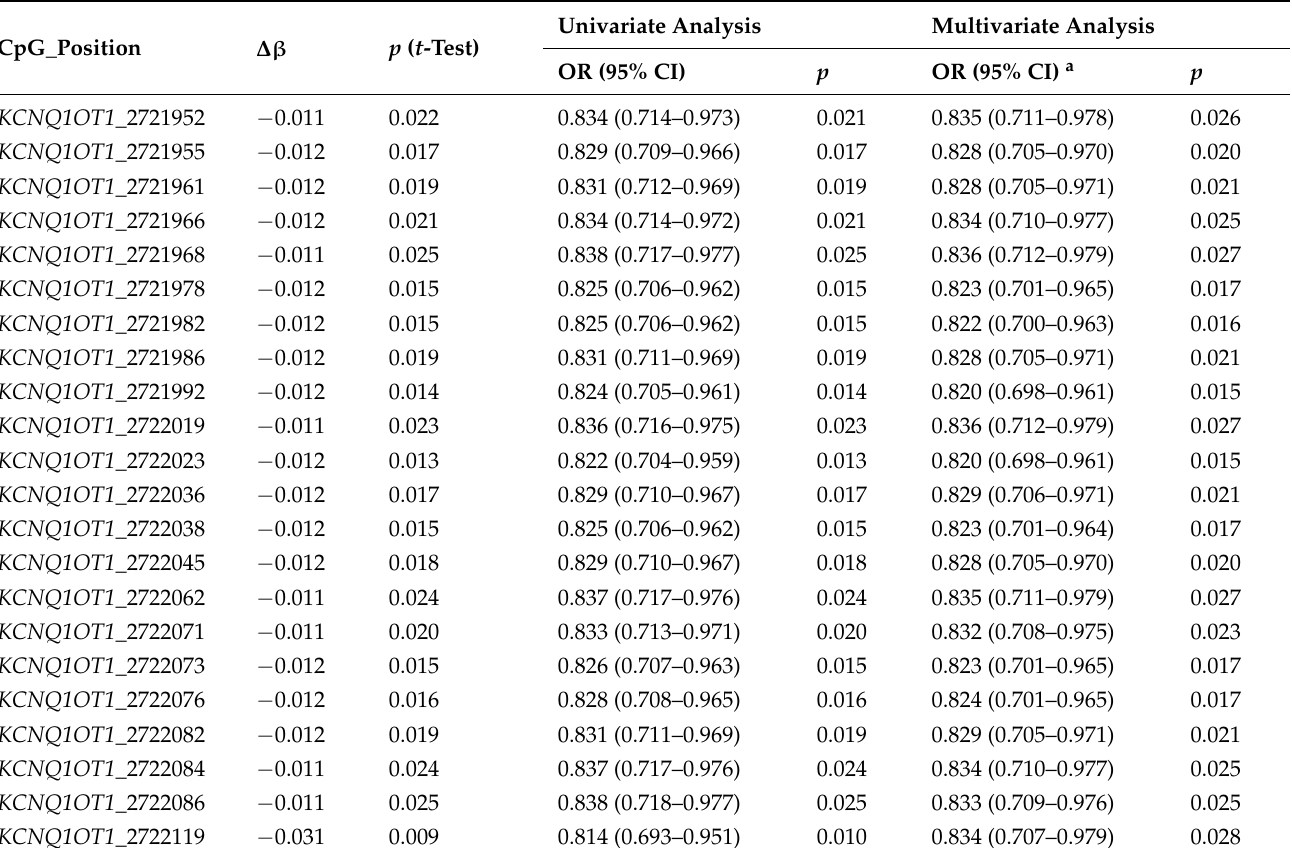
Table 2. The association between the CpG site methylation of KCNQ1OT1 and the risk of breast cancer in the validation